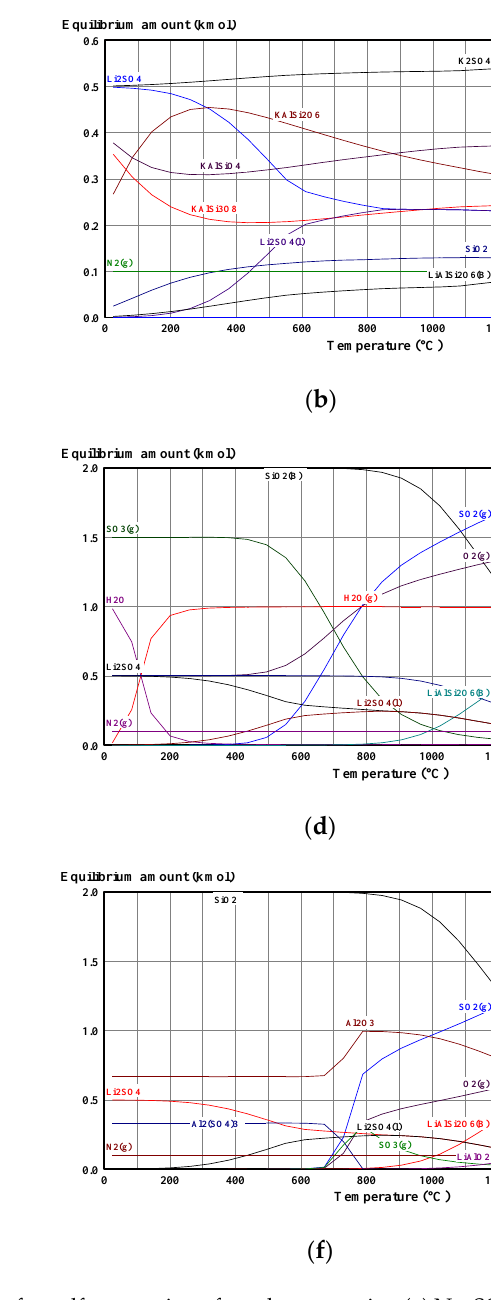
Figure 4. Equilibrium amounts versus temperature for alkaline roasting of spodumene using CaO (data from HSC Chemistry 5.1 software). Figure 5a–c shows the modelling of chlorination roasting using CaCl 2 , Cl 2 and KCl, performed experimentally by several authors [41,43,44,46]. From Figure 2, it is observed that the reactions with CaCl 2 and Cl 2 are favored at a point or in the entire temperature range, however, it is not feasible with KCl. This infeasibility is confirmed in Figure 5a where an appreciable mole of spodumene is observed in the equilibrium mixture. There is an onset production of solid LiCl which is converted into the liquid phase as soon as it is produced (Figure 5b,c). At ~610 °C (the melting point of lithium chloride) lithium chloride in the medium is predominantly in the liquid phase. A high volatilization